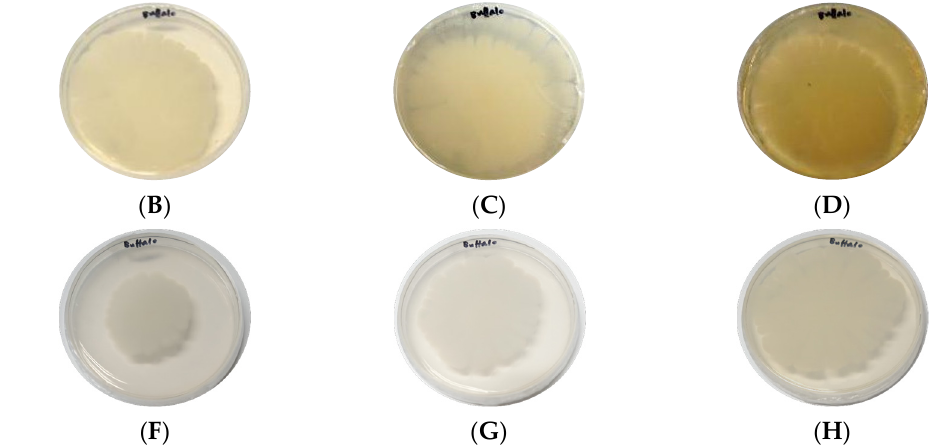
Figure 6. Colour reaction of guaiacol and kraft-lignin reduction. ( A ) guaiacol: 1 d. ( B ) guaiacol: 4 d. ( C ) guaiacol: 10 d. ( D ) guaiacol: 15 d. ( E ) control: 1 d. ( F ) control: 4 d. ( G ) control: 10 d. ( H ) control: 15 d.